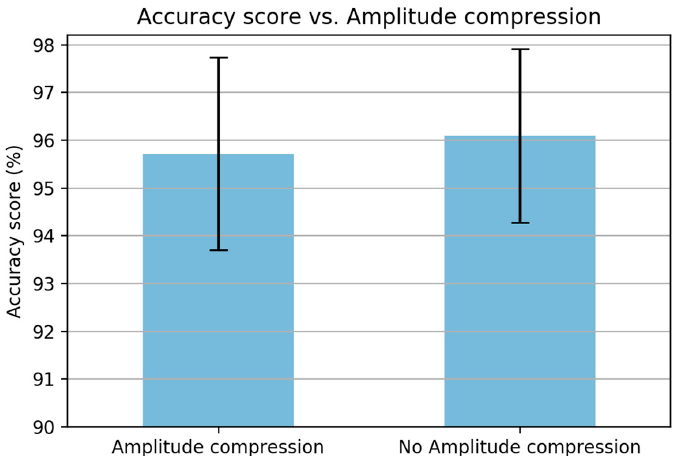
Figure 15. A comparison when removing the compression in PLP computation.